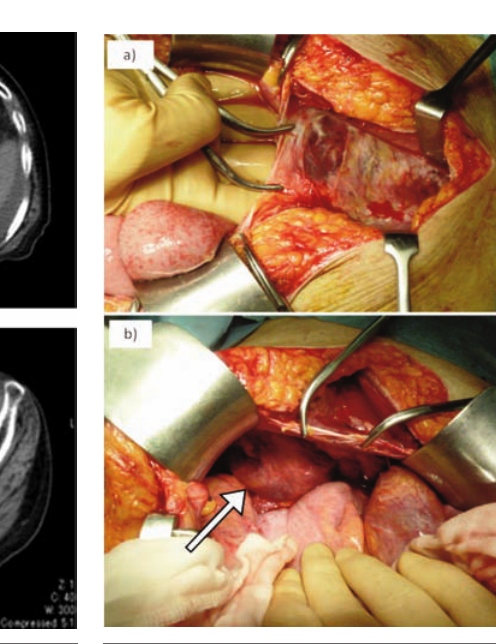
Figure 1. Abdominal computed tomogra- phy showing intra-peritoneal abnormal fluid collection (a), and gas accumulation in the pelvic space (b).